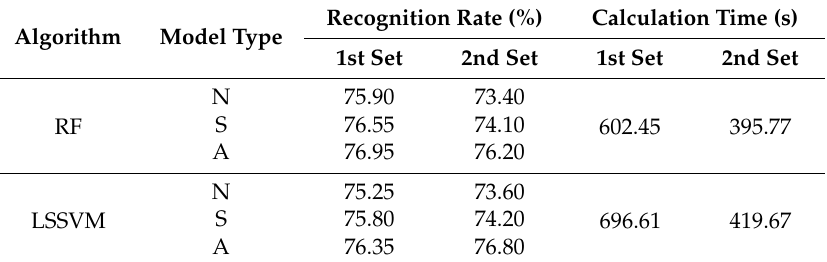
Table 5. Performance comparison results of 2nd